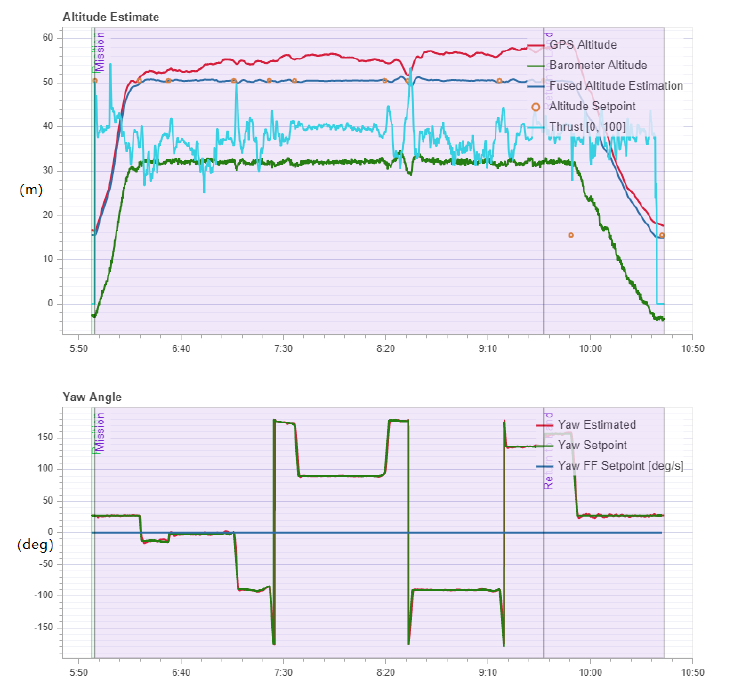
Figure 10. Altitude and attitude variation of the quadrotor during the hovering field